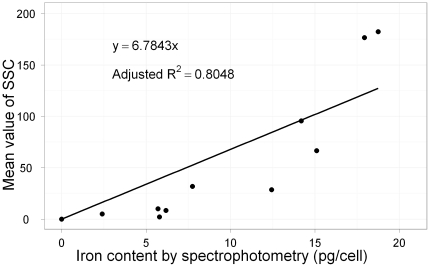
Linear correlation between iron content, as determined using a spectrophotometer, and the mean value of side scattering counts (SSCs), as measured by flow cytometry.Basal iron content and SSC were subtracted. There was a strong correlation between these two factors (P<0.001, R2 = 0.8048).